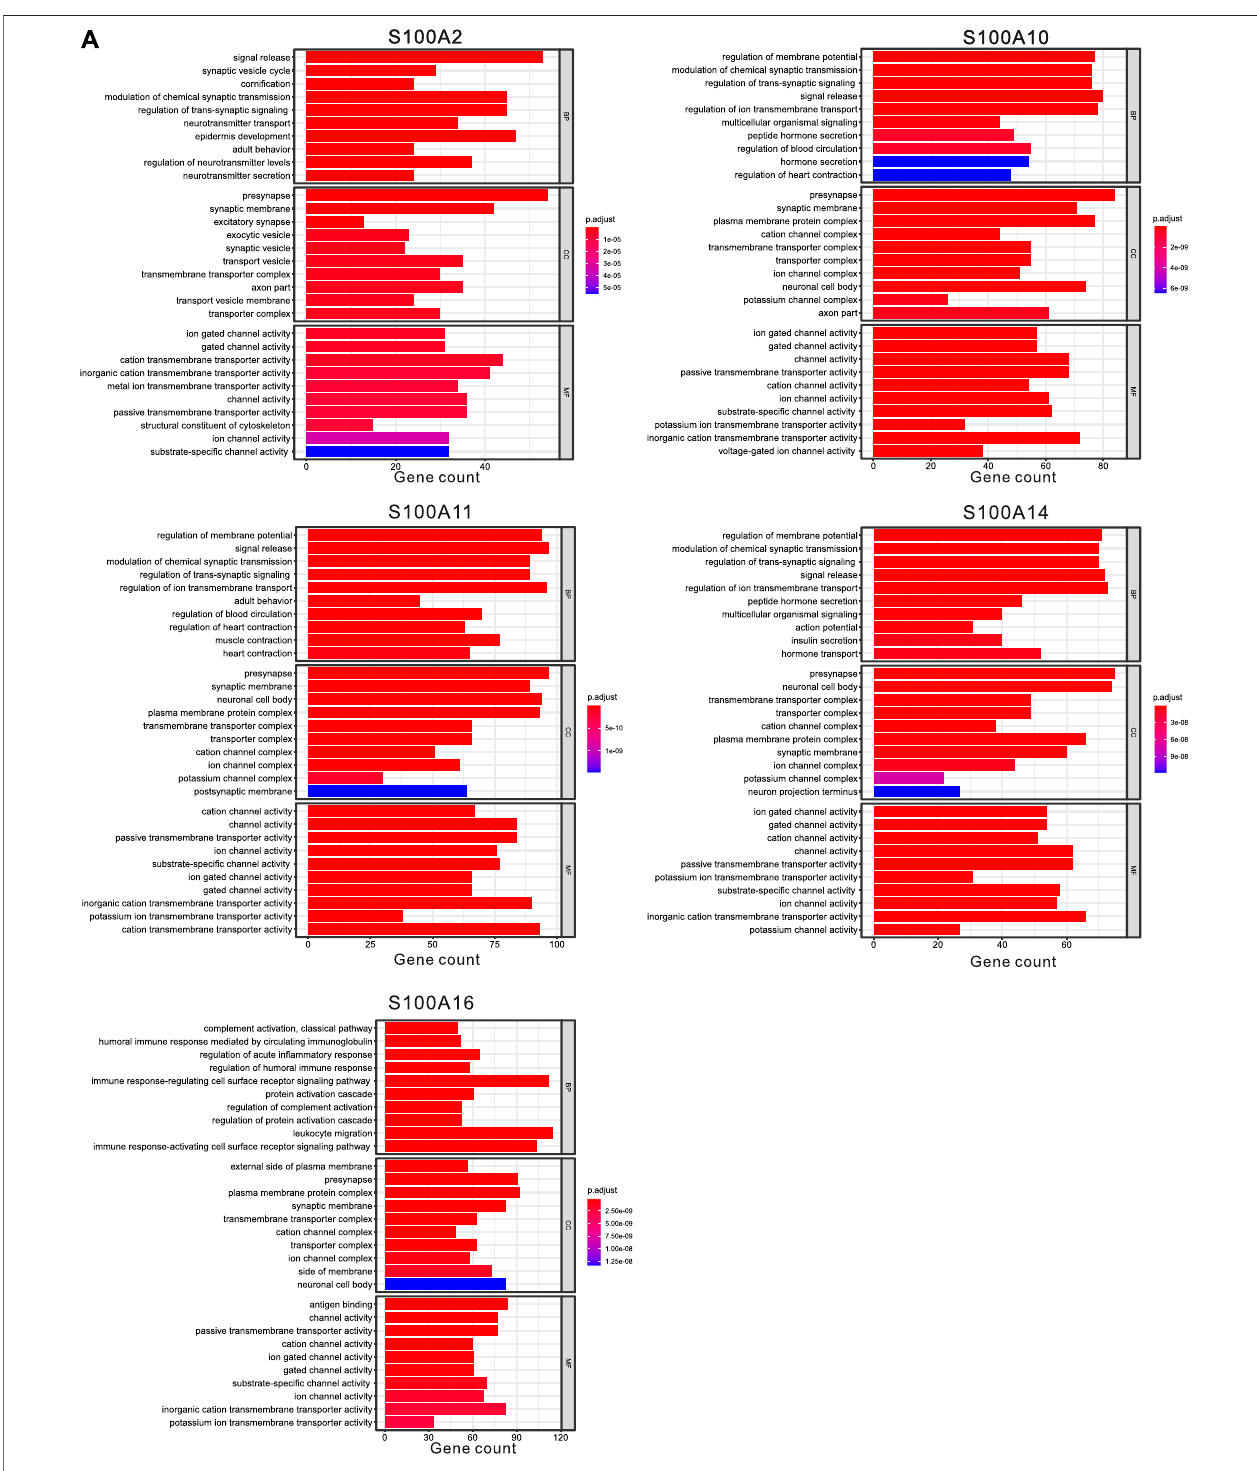
FIGURE 11 | Functional enrichment analysis of differential genes in samples with signi fi cant S100 gene high expression (top 25%) and low expression (bottom 25%) samples (calculated data from TCGA-PAAD, n (cid:1) 178). (A) GO enrichment analysis (BP: biological process; CC: cellular component; MF: molecular function). (B) Top 30 most signi fi cant KEGG